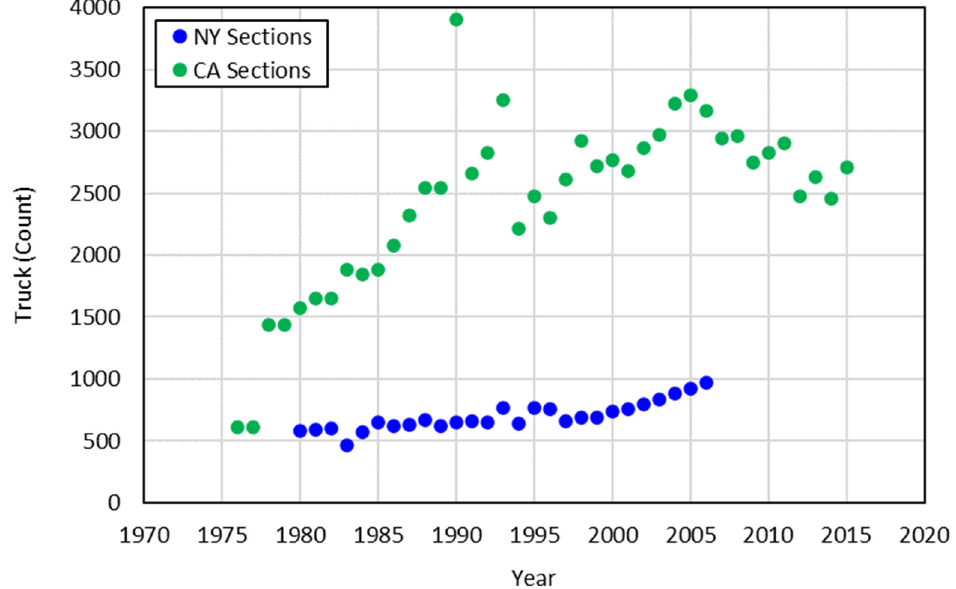
Figure 5. AADTT in NY and CA pavement sections (data source: [33]).